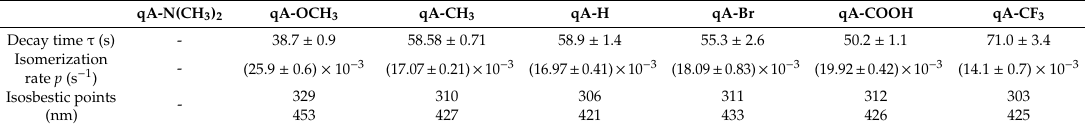
Figure 7. ( a ) Changes in absorption spectrum due to photoisomerization for qA-H sample. ( b ) Changes in absorption spectrum before and after irradiation for qA-H . ( c ) The evolution of the π - π * absorption band of qA-H as a function of the irradiation time. Table 4. Decay times, isomerization rates and isosbestic points for quinoline azo-dye polymer thin